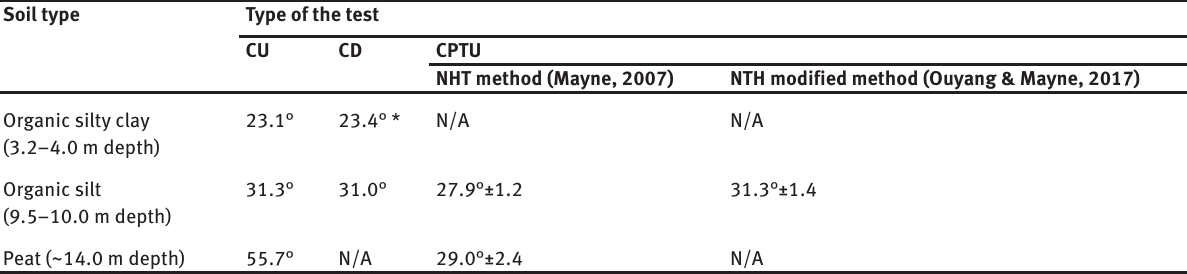
Table 2: Values of effective friction angle of soft soils in Jazowa.